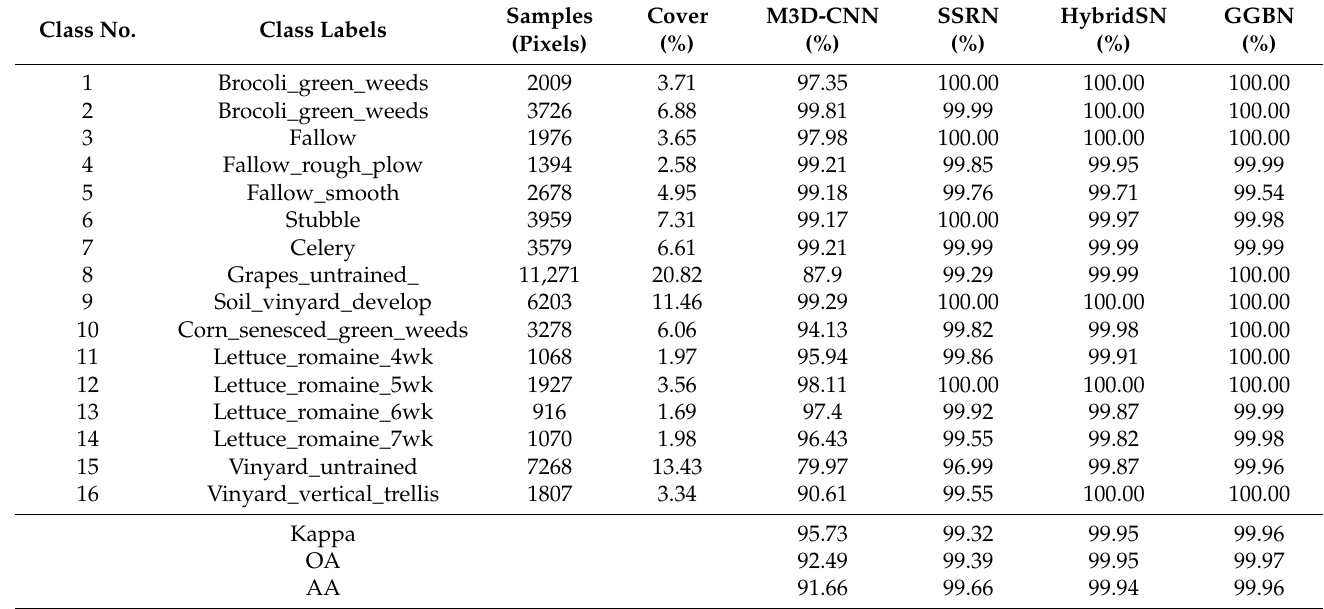
Table 4. Classification Results (%) over SA dataset.